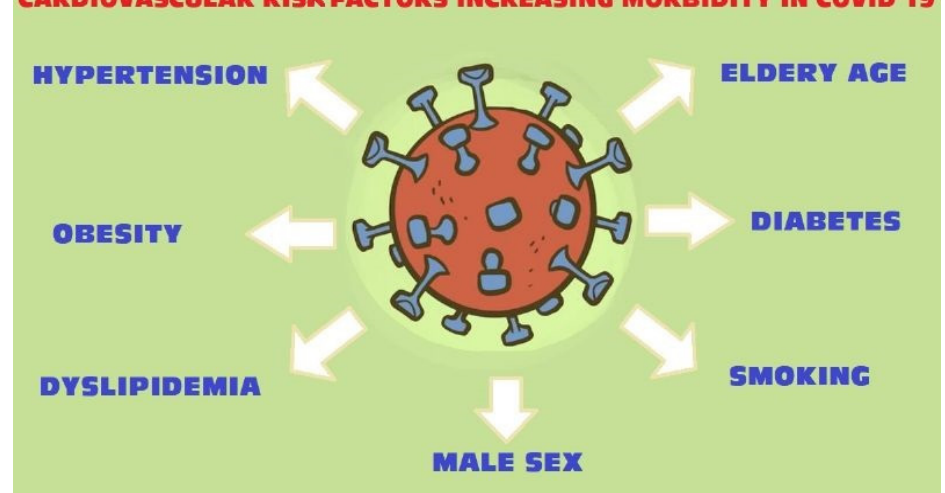
Figure 1. COVID-19 cardiovascular risk factors.